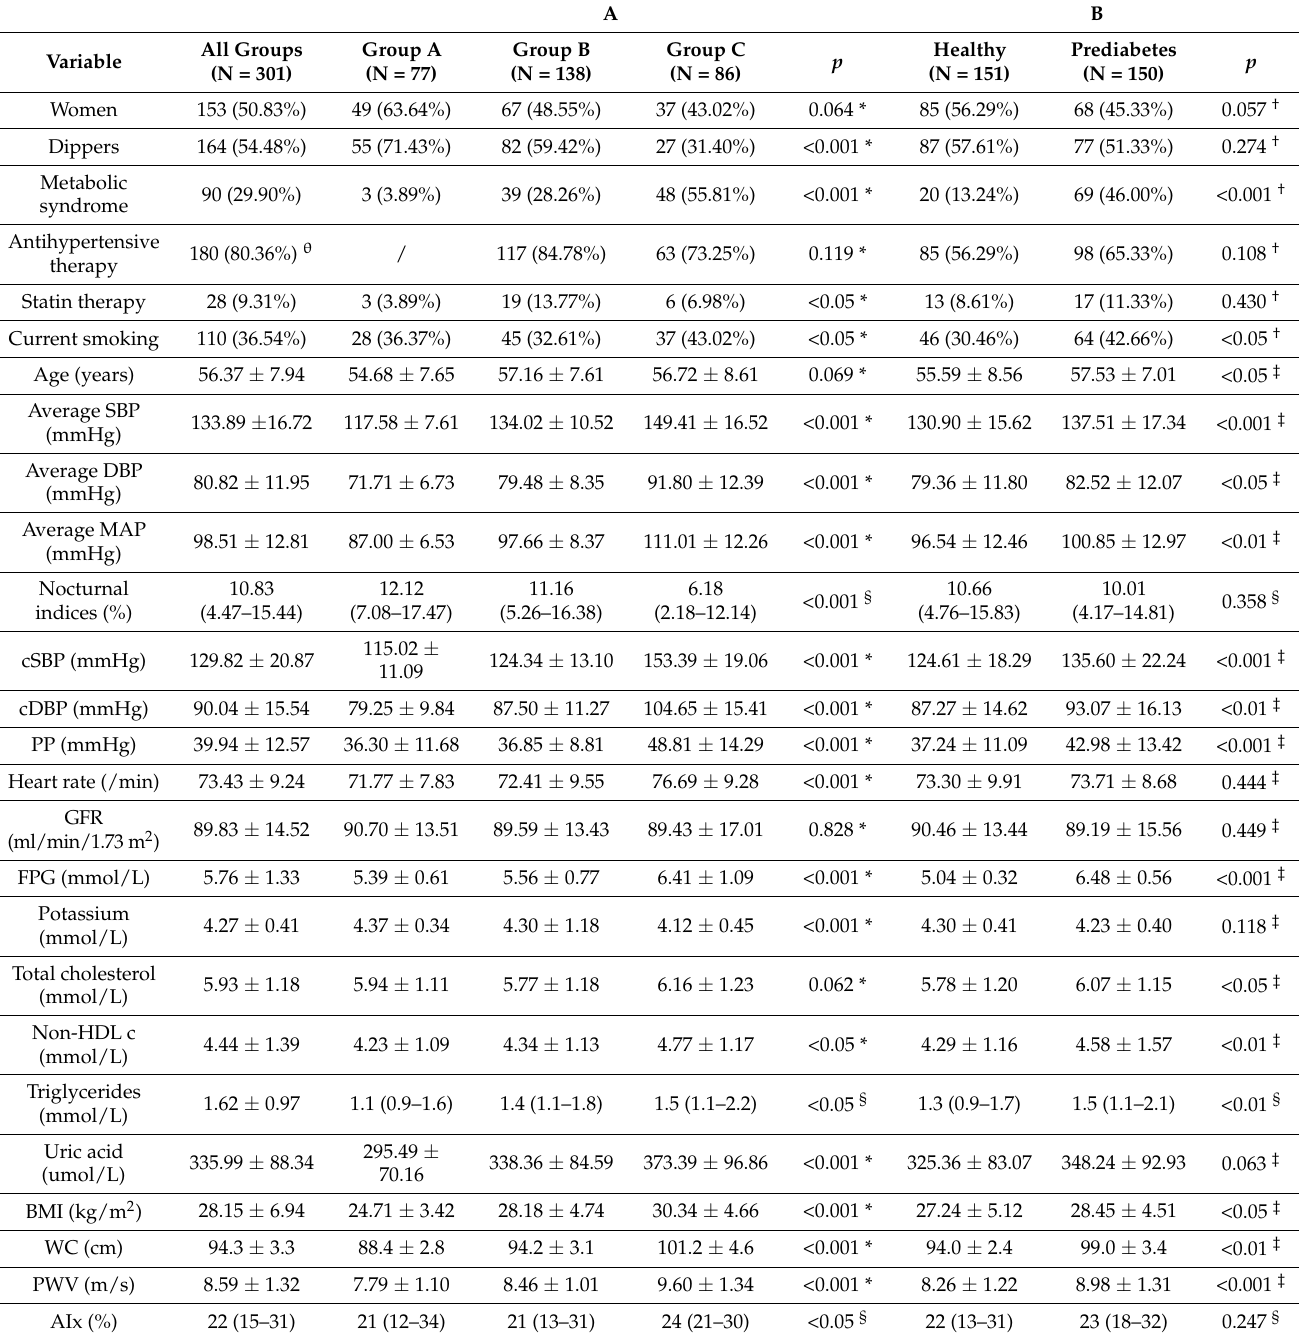
Table 1. —Differences between healthy subjects (group A), patients with regulated arterial hyperten- sion (group B) and patients with untreated hypertension (group C). B—Differences between healthy and prediabetic subjects (right side). All data are listed as number (percentage), mean ± standard deviation or median (interquartile